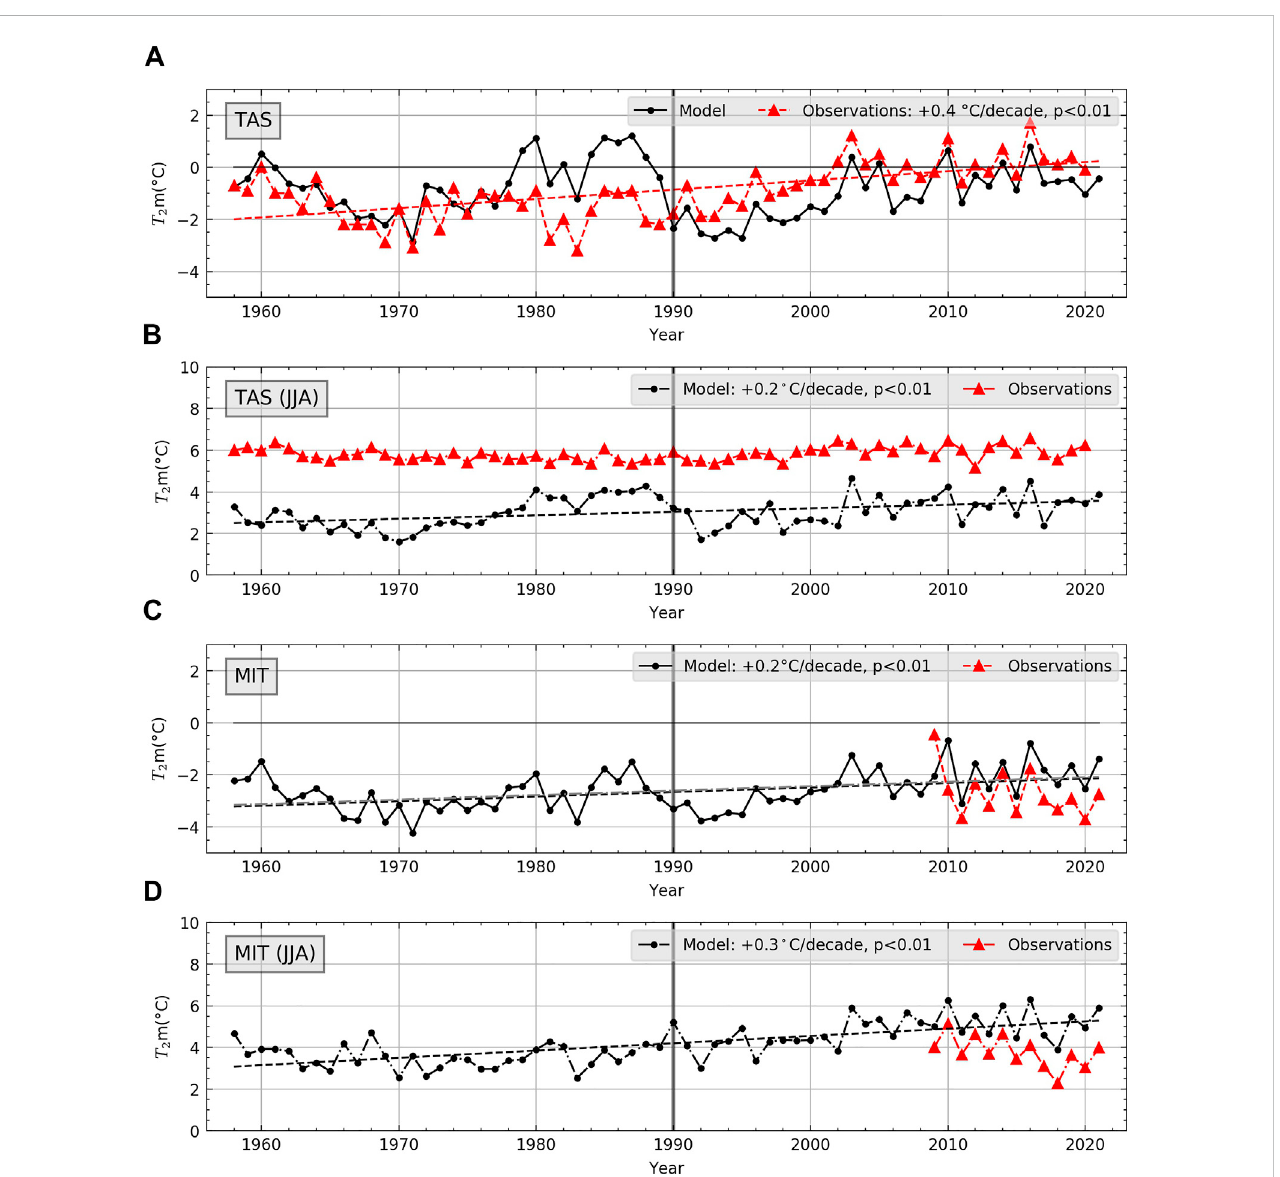
FIGURE 3 Annual average T 2m trends for two locations on Ammassalik island. Modelled (RACMO2-5.5 km for TAS and RACMO2-1.0 km for MIT) T 2m values are indicated with black dots. Observed (DMI-TAS) and (GEUS-MIT) T 2m values are indicated with red triangles. Subpanels depict annual average T 2m at TAS (A) , summer annual averages at TAS (B) , annual average T 2m at MIT (C) and summer annual averages at MIT (D) . Linear trends for the 1958-2021 period are calculated with the Sen ’ s slope and shown as dotted